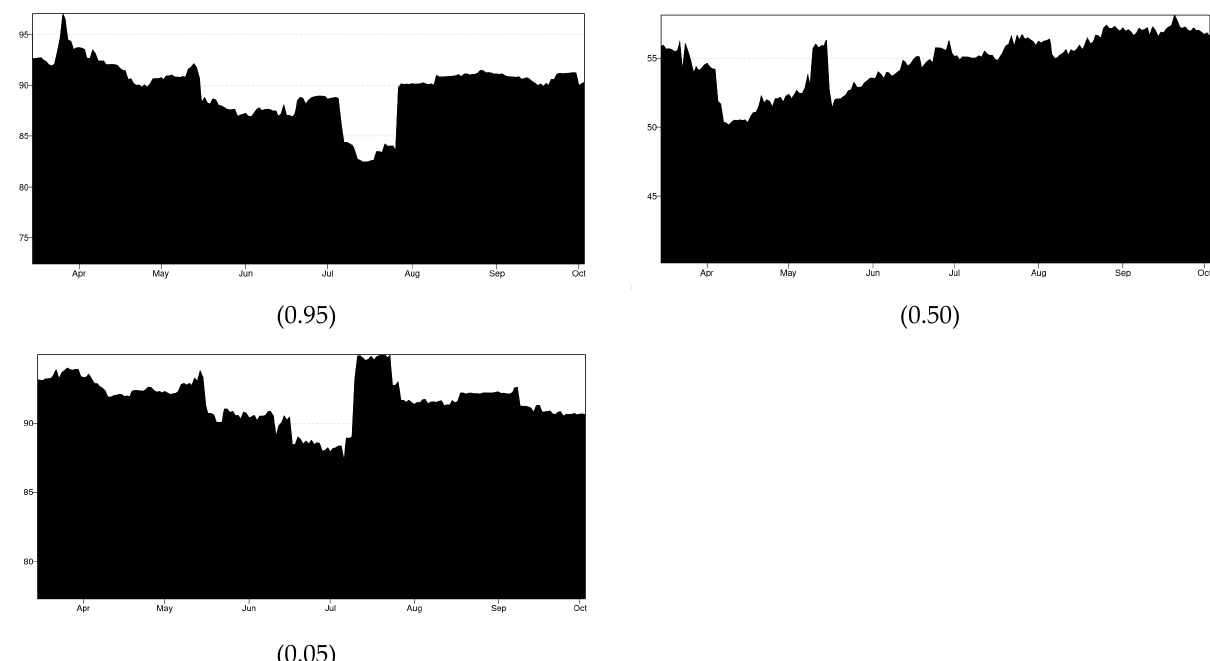
Figure 2. Total connectedness/spillover index at three quantiles (0.95, 0.50, and 0.05). The figure below (Figure 3) represents a network plot for the connectedness across the smart contract market across quantiles. Blue (yellow) nodes indicate net shock transmitters (receivers) and the size of the nodes corresponds to the absolute values of the NET connectedness index. The direction of the arrows denotes the direction of spillovers between two variables and the thickness of the arrows indicates the strength of these spillovers. Fabric is Hyperledger Fabric, ETH is Ethereum, Waves is Waves, XTZ is Tezos, ALGO is Algorand, XLM is Stellar, and XEM is NEM.